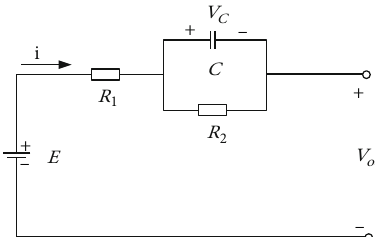
Figure 1: The fi rst-order RC circuit